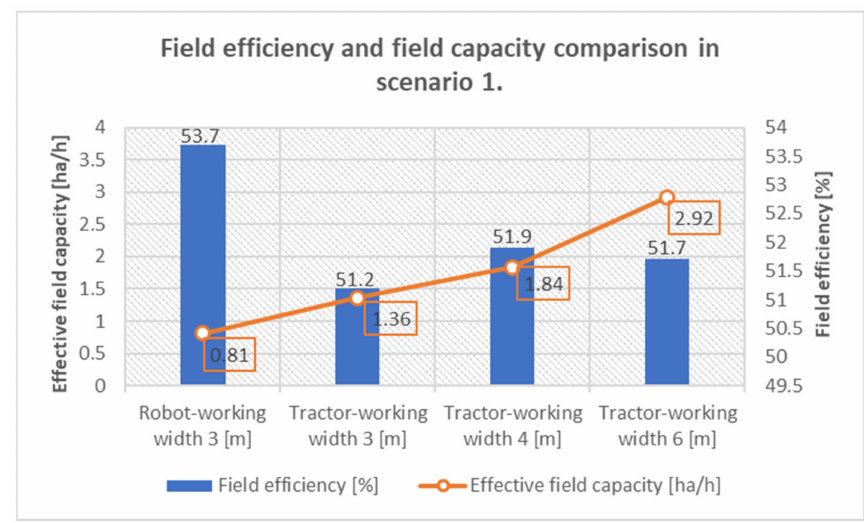
Figure 10. Comparison of field efficiency and field capacity for robot and tractor in scenario 1.